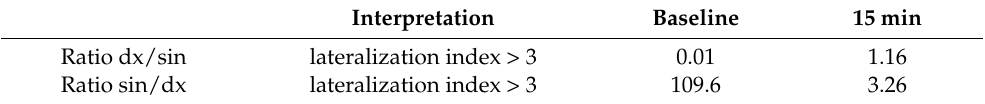
Table 4. AVS results for Case 3 (aldosterone lateralization measured with 17 hydroxyprogesterone